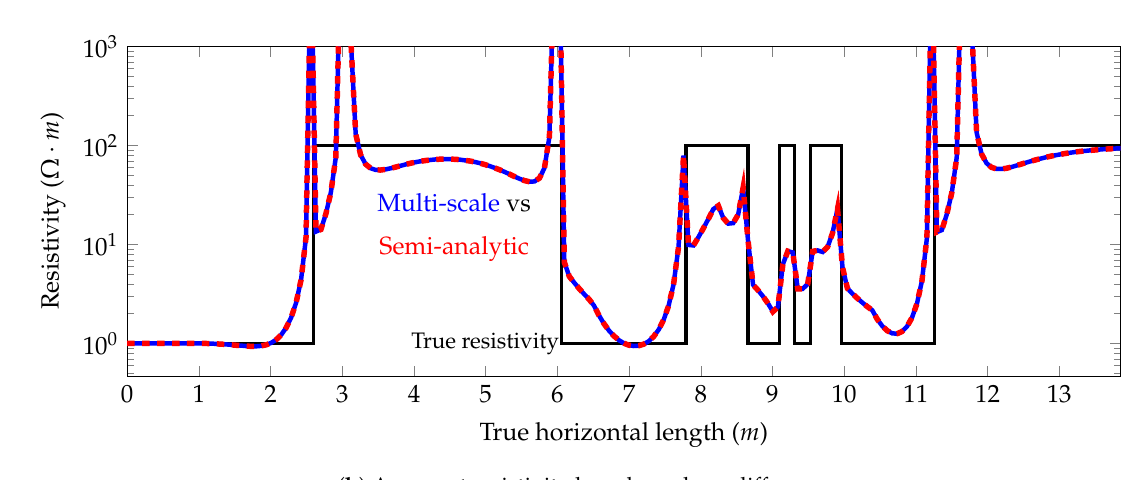
Figure 16. Model problem 2. Apparent resistivity for the zz coupling for a 60 ◦ deviated well.